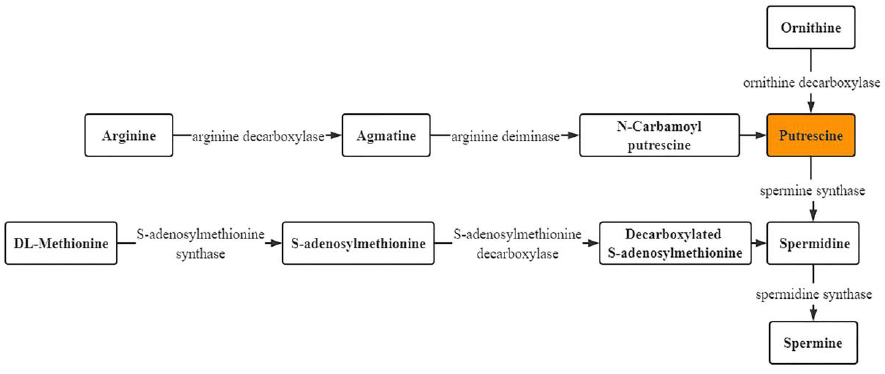
Figure 1. Anabolic pathways of polyamines.